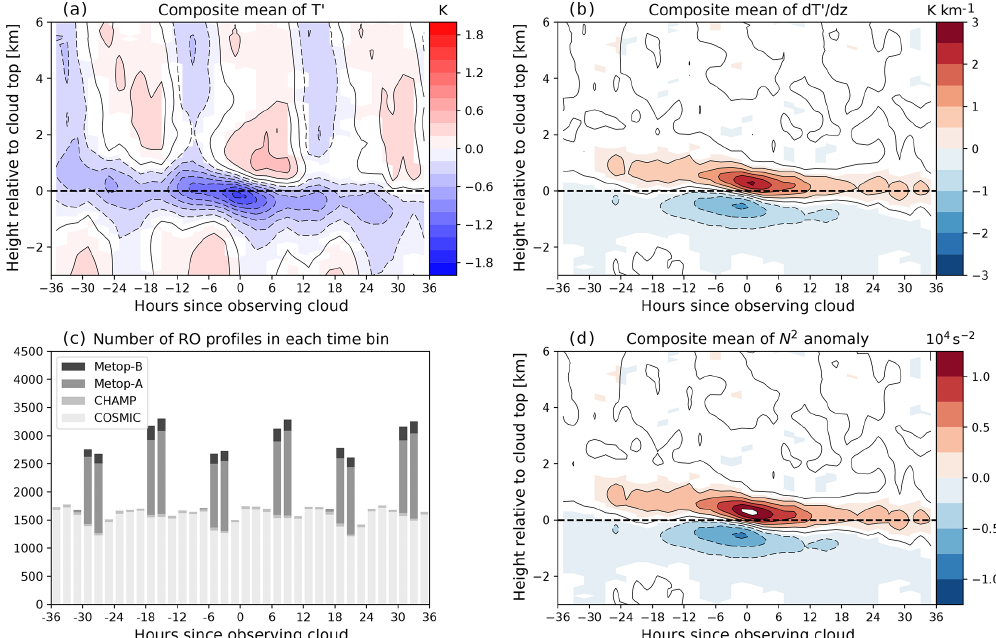
Figure 6. Composite of (a) T (cid:48) , (b) d T (cid:48) / d z , and (d) buoyancy frequency N 2 anomaly in height coordinate relative to cloud top. Colored contours in these three plots are at or above the 95% significance level according to the Student’s t test. Solid (dashed) contours represent positive (negative) anomalies and are at the same levels as the colored contours. The abscissa denotes the time offset between the CALIPSO observation and RO sounding. (c) shows the number of unique RO profiles in each 2h time bin used to calculate the composites.